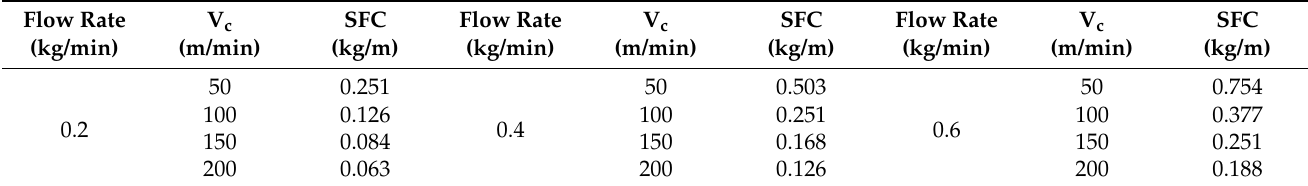
Table 2. The values of specific fluid consumption at various combinations of coolant’s mass flow rate and cutting speed. Flow